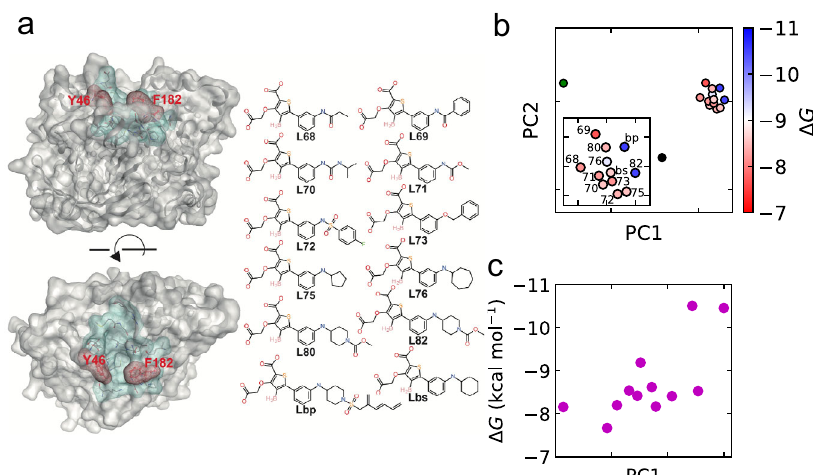
Fig. 4 Ligand-induced dynamics in the phosphatase 1 B (PTP1B) systems. a Molecular surface of PTP1B (Protein Data Bank ID: 1OEM) superimposed on ribbon diagram (left column). The green and red meshed molecular surfaces indicate the ligand binding site. The key residues (Tyr46 and Phe182, see Supplementary Fig. 19) are shown in red meshed molecular surfaces on ball and stick models with labels, respectively. These two residues were identi fi ed